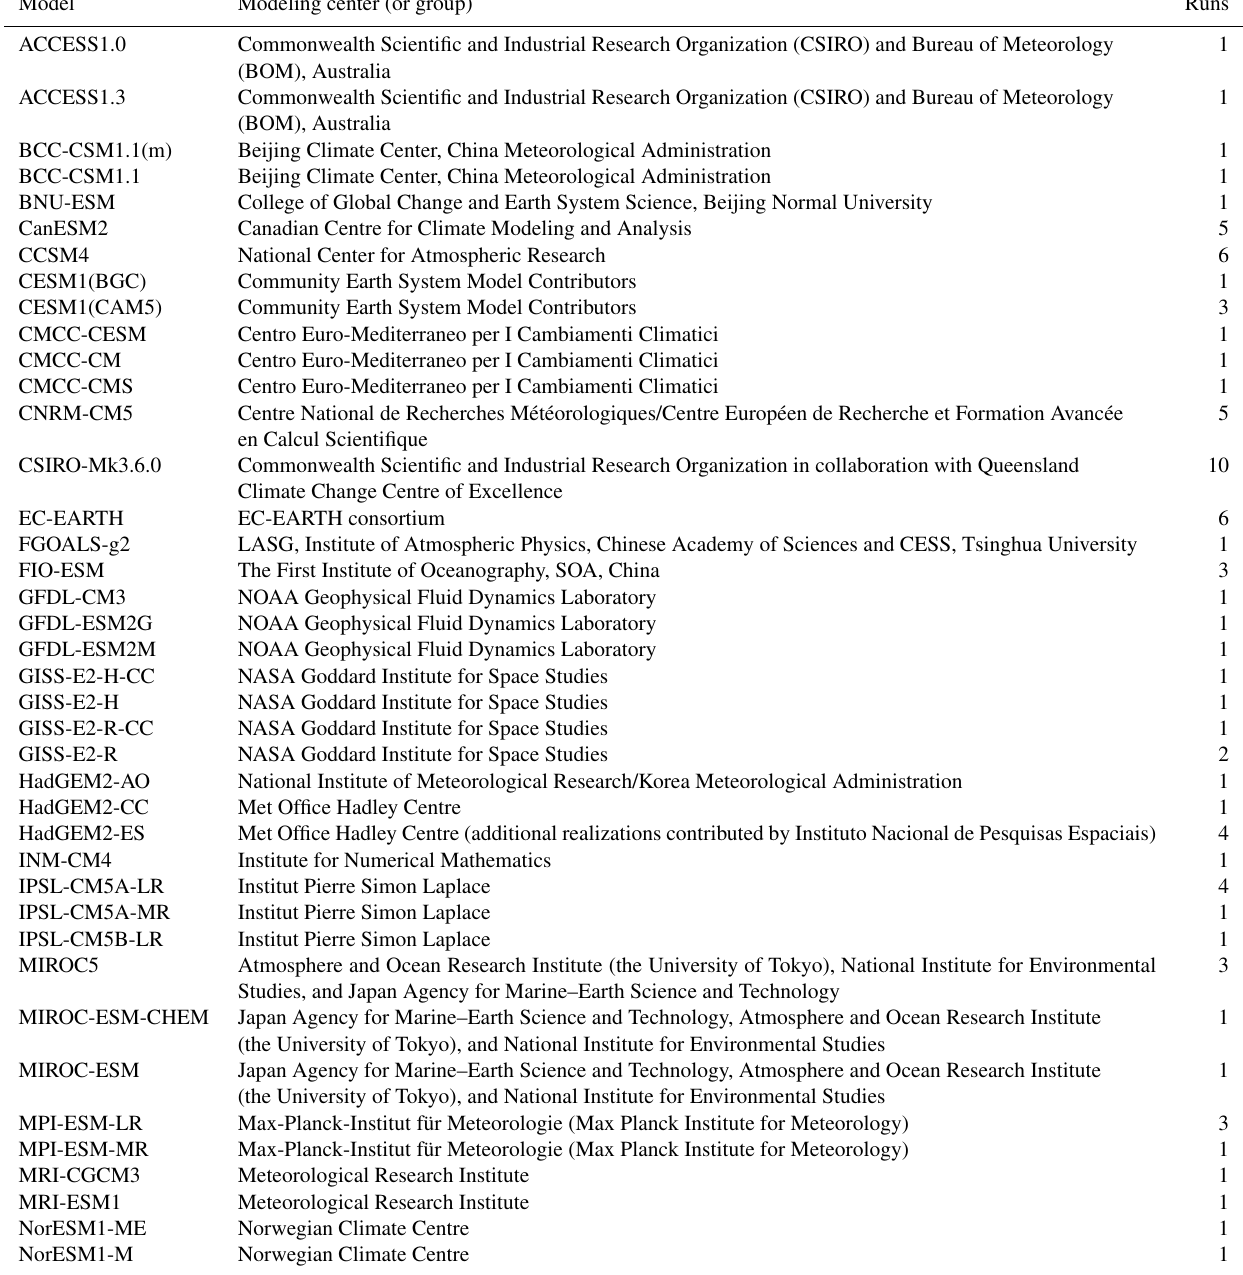
Table A1. List of the 40 employed CMIP5 models, the modeling groups providing them, and the number of initial-condition ensemble members